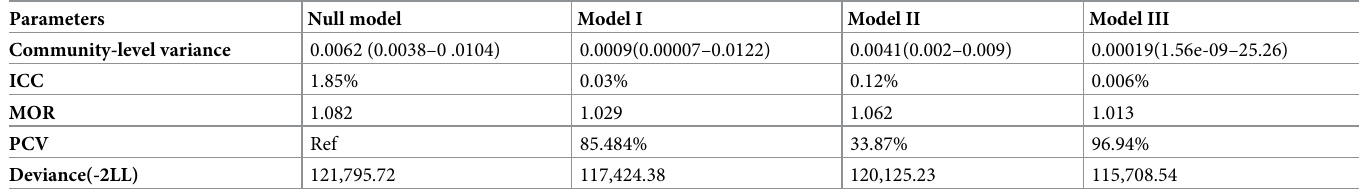
Table 2. Random effect analysis and model comparison